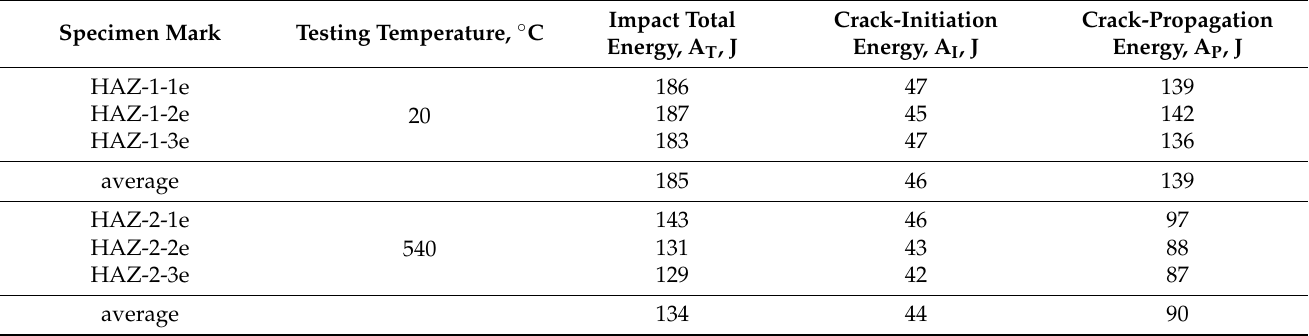
Table 9. Results of impact testing for A387 Gr. B—HAZ